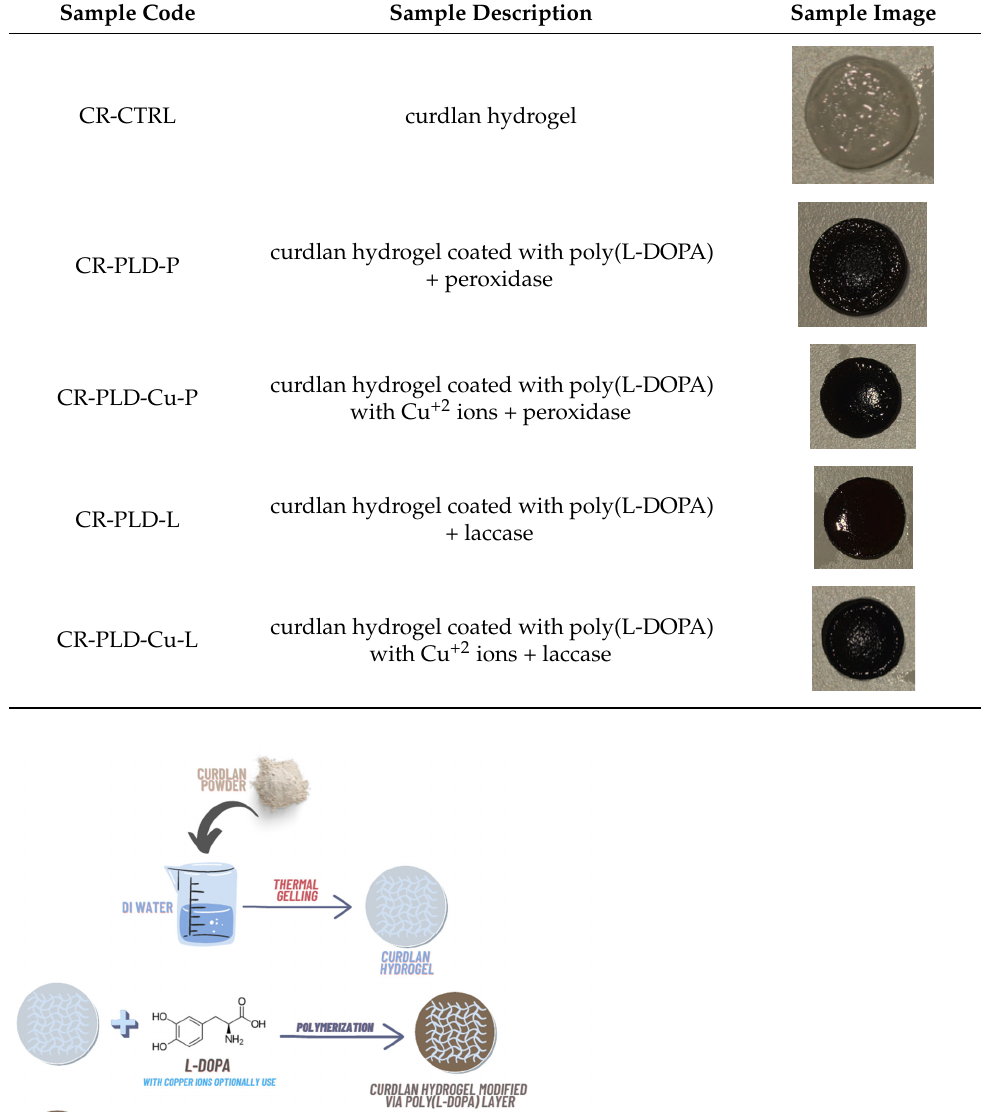
Table 2. Sample codes and images.